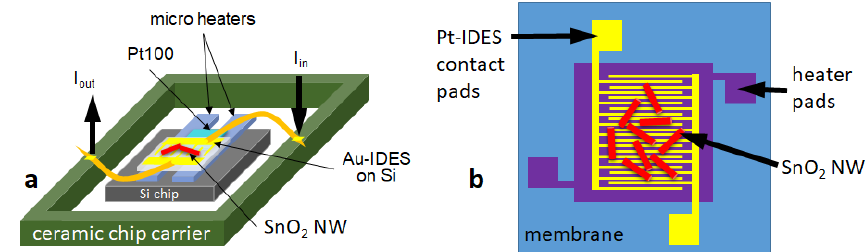
Figure 3. ( a ) SnO 2 NWs transferred on SB sensor, ( b ) SnO 2 NWs transferred on microhotplate-based sensor.